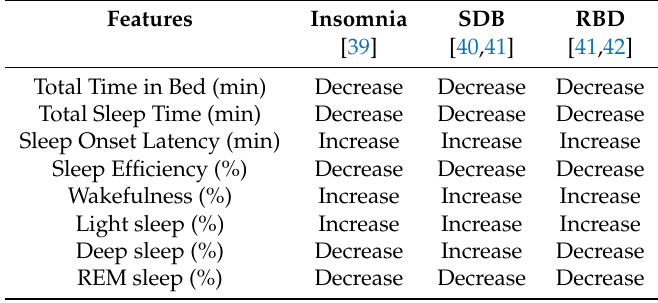
Table 2. Sleep quality parameters of insomnia, Sleep-Disordered Breathing (SDB) and REM Behavior Disorder (RBD)